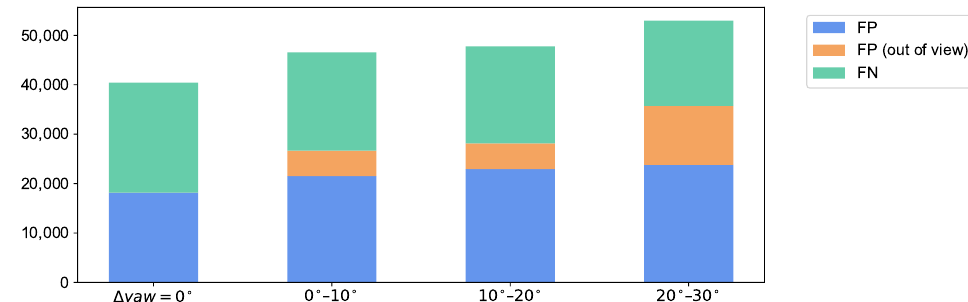
Figure 11. A summary of the errors in the proposed network. The bars show the percentage of each error in the proposed method for the separate scales of viewpoint differences between the images. FP denotes false positive results (except for FP (out of view) as FP (out of view) represents false positive results that occurred because of an object moving out of the field of view) and FN represents false negative